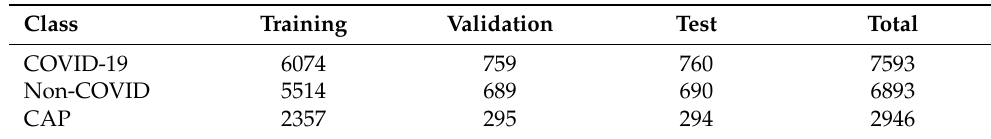
Figure 1. Illustration of six representative Computed Tomography (CT) images of the three different classes: community-acquired pneumonia (CAP), COVID and non-COVID. Table 2. Class distribution in the training, validation and test for Non-COVID, COVID and Community-acquired pneumonia